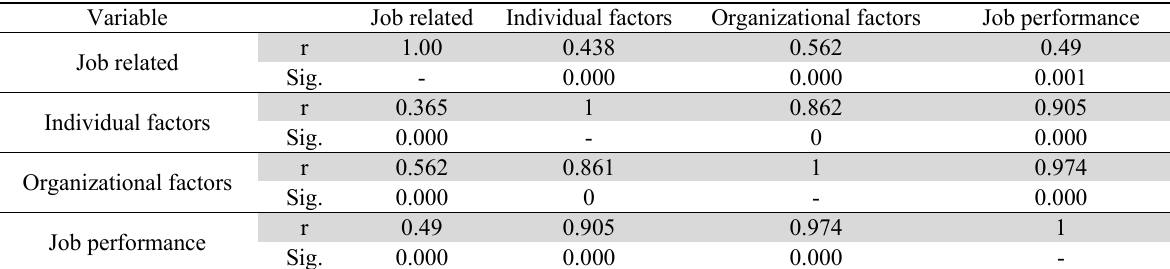
The results of Pearson